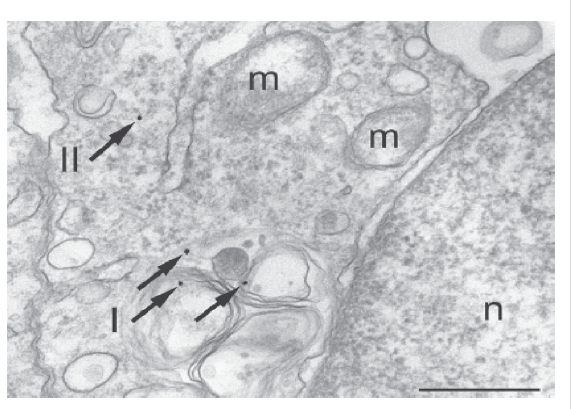
Figure 6: Intracellular compartments after internalization of PEG- coated gold NPs as visualized with TEM. The NPs (which are individu- ally resolved due to the high lateral resolution of TEM) are located within a lysosome (arrows I) and in the cytosol (arrow II). m and n demark the nucleus and mitochondria, respectively. The scale bar corresponds to 500 nm. Adopted from with permission from [68]. Copy- right 2010 Wiley-VCH Verlag GmbH & Co. KGaA,